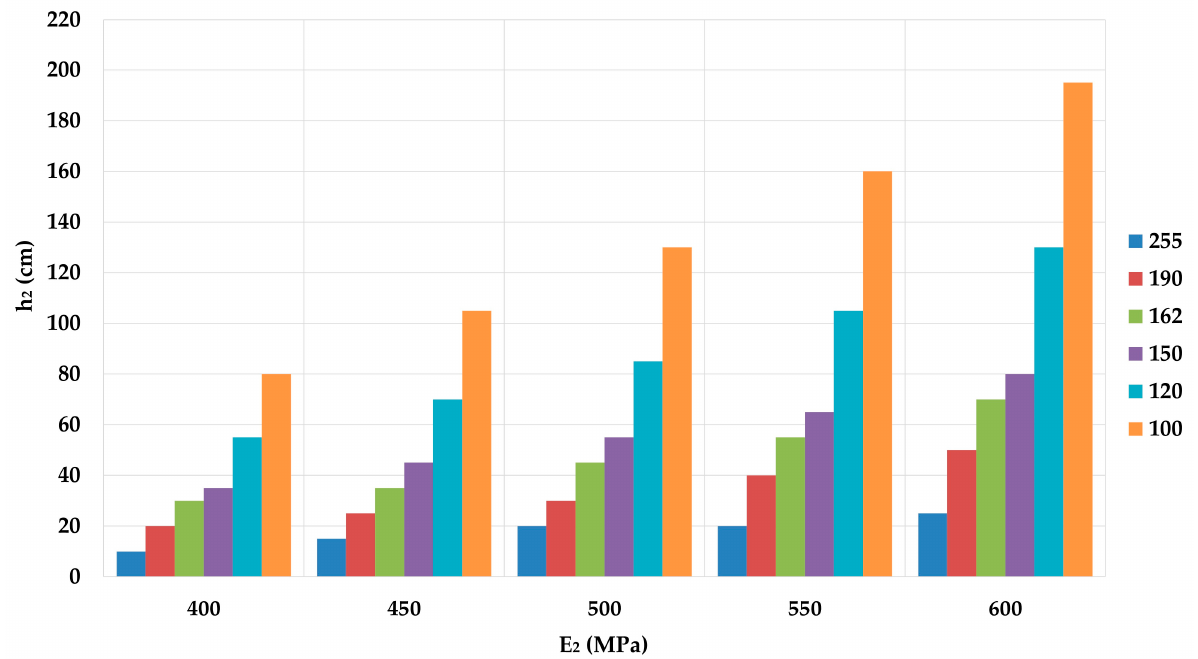
12 Figure 7. Comparison of k from the reviewed correlations. In Figure 8, the values of h 2 in cm, estimated through Equation (11), are presented. The thickness h 2 generally increases as the modulus of elasticity increases. Considering the minimum values of k for the Green and Hall [31] correlation, h 2 varies between 10 and 25 cm. Overall, the Green and Hall [31] and Hopkins et al. [34] correlations require the